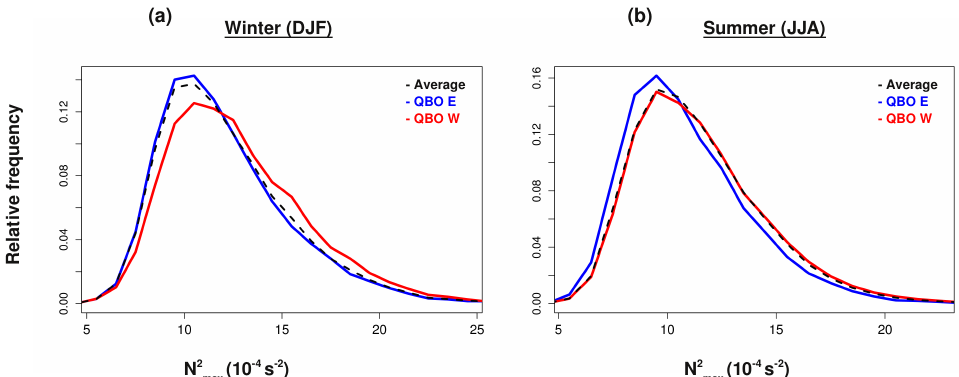
Figure 4. Histograms with relative frequency of TIL strength ( N 2 max ), for winter ( a , DJF) and summer ( b , JJA). The black dashed line denotes the average seasonal distribution. The blue line shows distributions during the easterly phase of the QBO in the lowermost stratosphere, and the red line shows the distributions during the westerly QBO